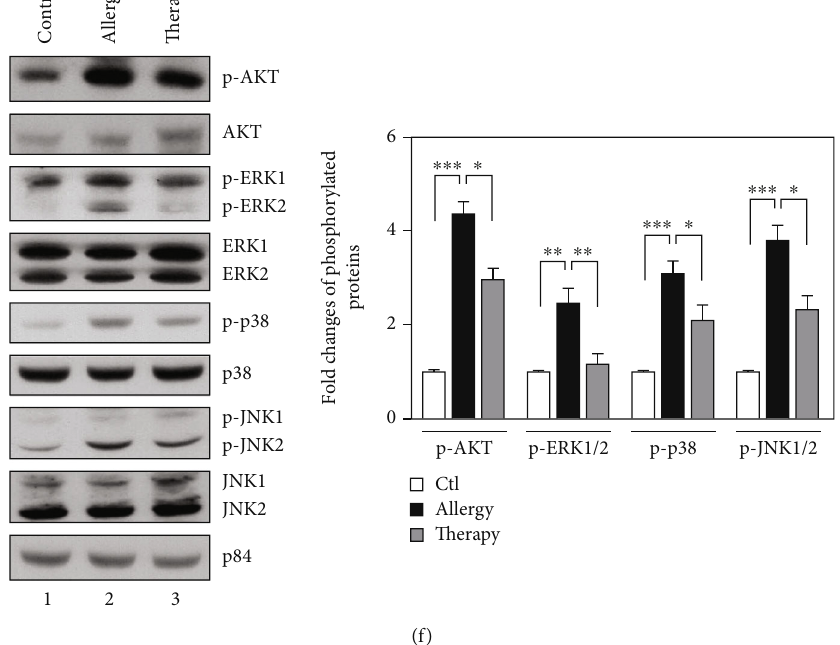
Figure 4: PTX3 increases degranulation, production of in fl ammatory mediators, and activation of the Fc ε RI signaling pathways in RBL-2H3 cells mimicking shrimp allergy. (a) Three-to-four-week-old female BALB/c mice ( n = 6 per group) were intraperitoneally sensitized with PBS, shrimp extract or recombinant tropomyosin peptides, and challenged by a high dose of shrimp extract. Using Al(OH) adjuvant, shrimp allergy mice received either 10mg of shrimp extract or 1 mg of tropomyosin peptides in PBS i.p. on days 1, 4, 7, 10, 13, 16, 19, and 22. Blood was collected after the challenge with 50mg of shrimp extract on day 30. (b, c) Levels of serological total IgE and PTX3 were determined by ELISA. (d) RBL-2H3 cells were incubated with sera from the various groups overnight and further stimulated with shrimp extract for 15 min. β -hexosaminidase activity was determined as described in the Materials and Methods. (e) E ff ects of sera from the various groups as indicated on the mRNA levels of TNF- α , IL-4 , IL-6 , IL-13 , and COX-2 in serum-treated RBL-2H3 cells. (f) E ff ects of sera from the various groups on Fc ε RI signaling pathways in serum-stimulated RBL-2H3 cells. Total lysates were harvested for western blot analysis using antibodies as indicated. The quantitative analysis of phosphorylated proteins is shown in the